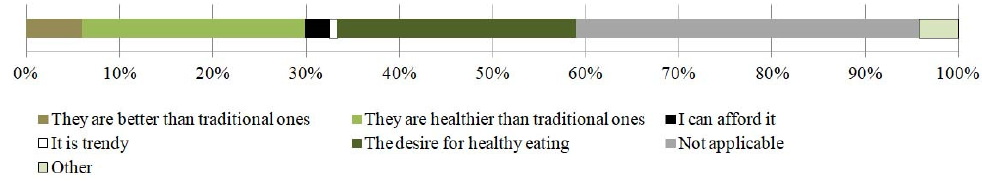
Figure 5. Reasons for purchasing organic vegetables [%].